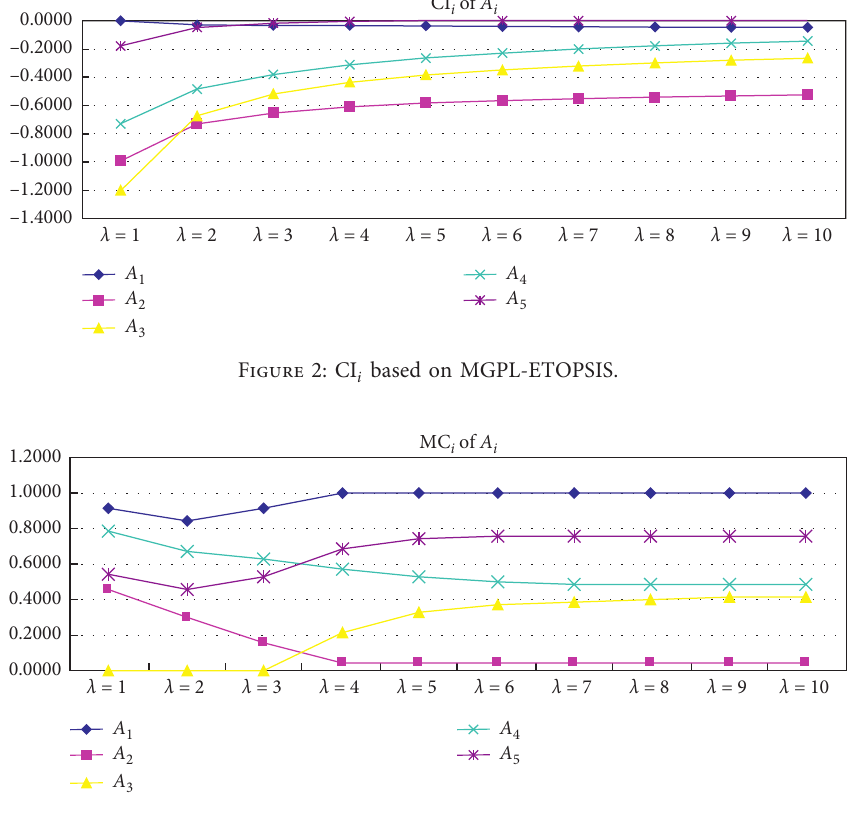
Figure 3: The MC i based on MGPL-VIKOR. Table 16: The ration CP � 0 . 85 , θ � 4 . 1 , and β � 0 . 85). i based on PT ( α